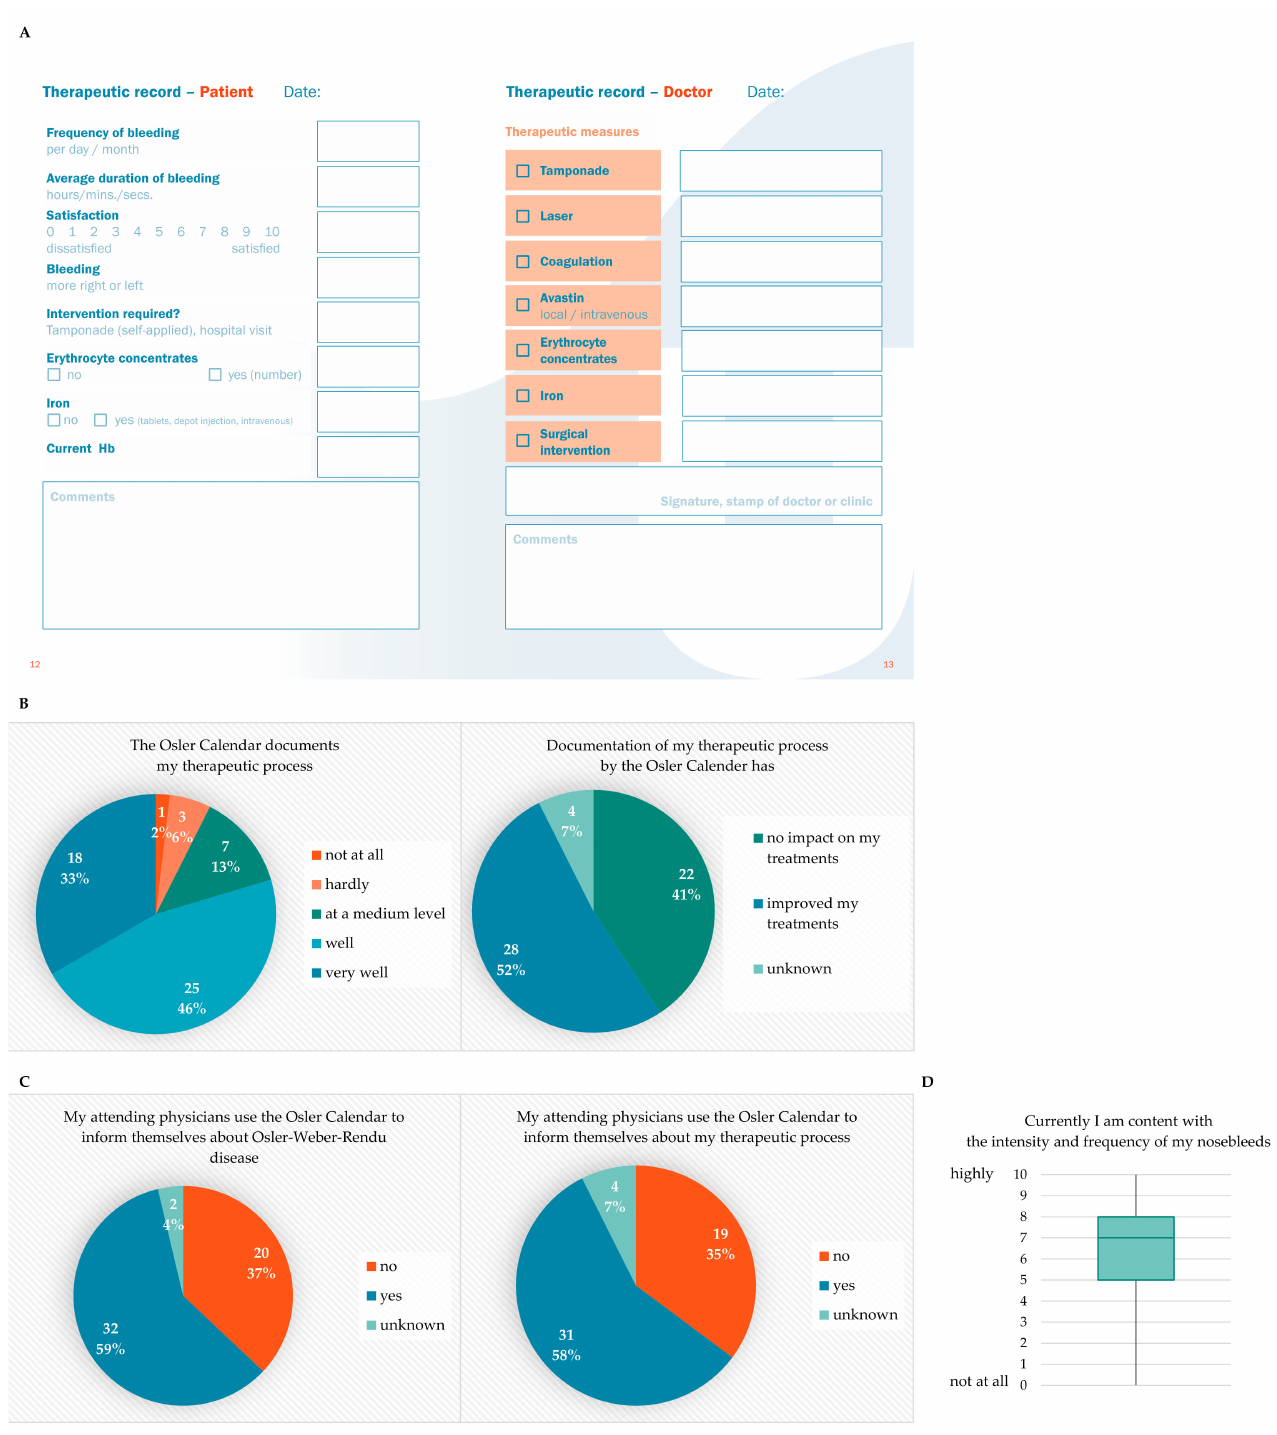
Figure 3. ( A ) Documentation of epistaxis treatment and patient outcome. ( B ) Use of the Osler Calendar for documentation of the therapeutic process. ( C ) Use of the Osler Calendar by attending physicians. ( D ) Patients’ satisfaction with intensity and frequency of